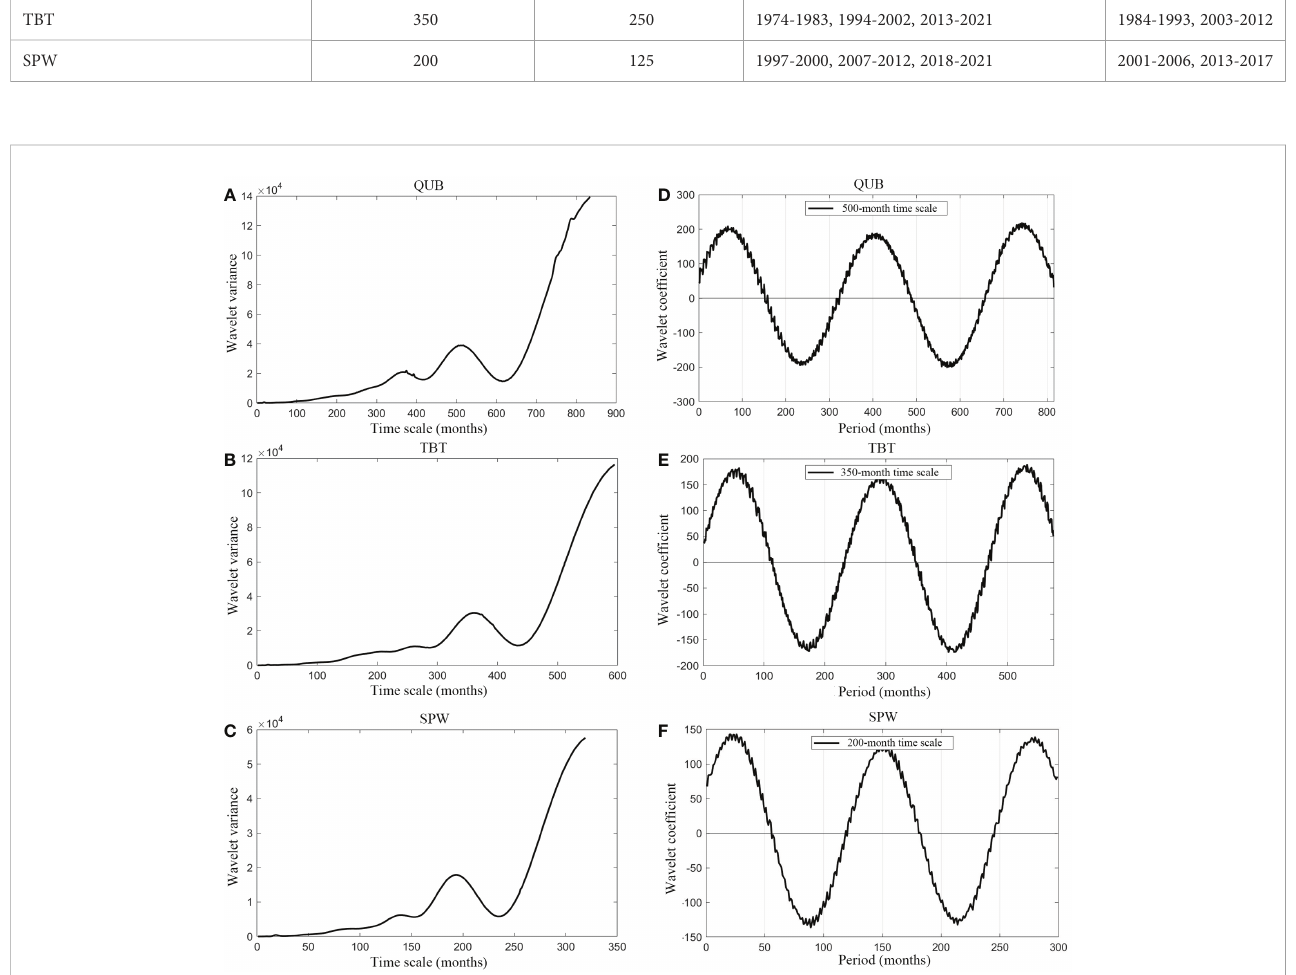
FIGURE 3 Wavelet variance and wavelet coef fi cient at different tide gauges. (A – C) are wavelet variances at the QUB, TBT, and SPW tide gauge stations, respectively. (D – F) are the wavelet coef fi cient of QUB, TBT, and SPW at their fi rst major period,